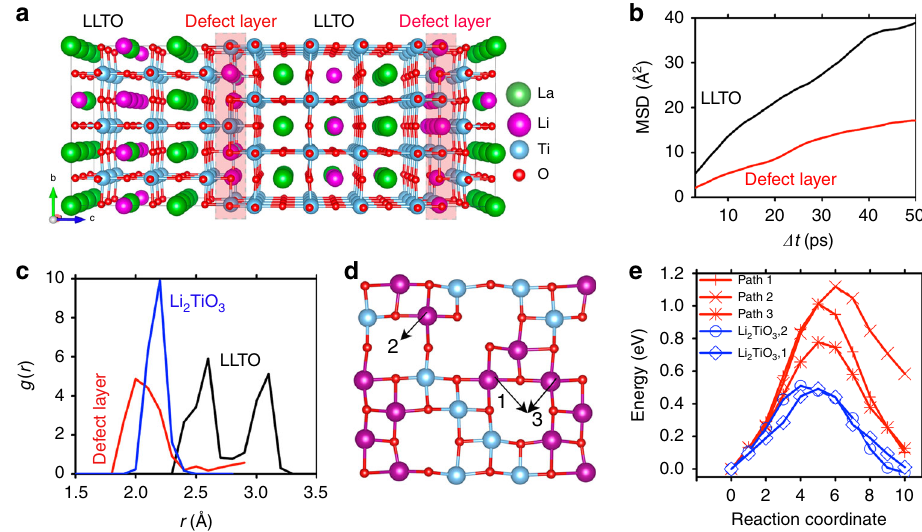
Fig. 4 Strain variation across the 2D defects. a HAADF-STEM image of a 2D defect with the adjacent LLTO oriented along ½ 1 (cid:1) 10 (cid:2) ( c ) strain maps obtained by performing GPA on the image in a . The scale bars in a – c are all 5 Å.